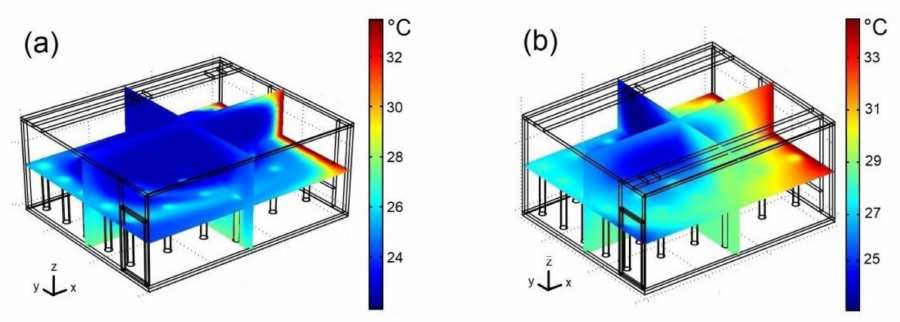
Figure 6. Temperature fields for: ( a ) case III; ( b ) case IV. Re = 15,000, 3:30 p.m. and C s = 37,500